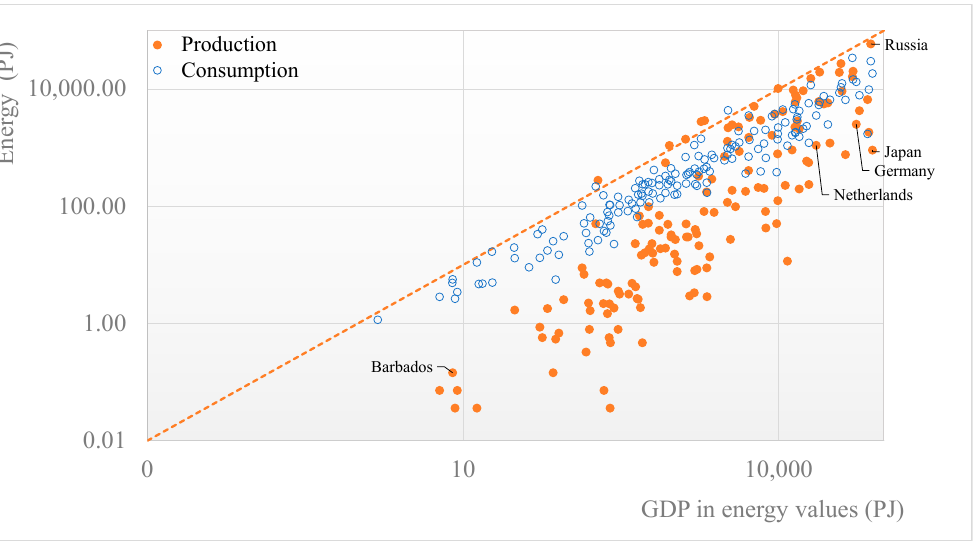
Figure 7. GDP expressed in energy units (PJ) correlated with primary energy production and energy consumption in different countries (2019).